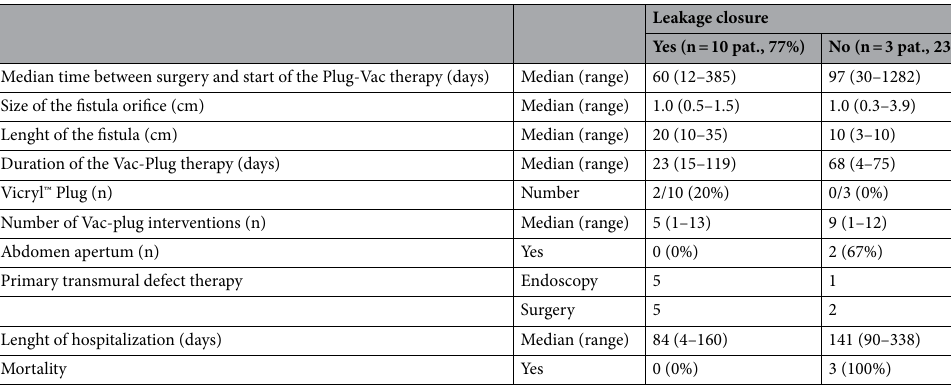
Table 2. Results and comparison of the treatment success (One patient was excluded due to short